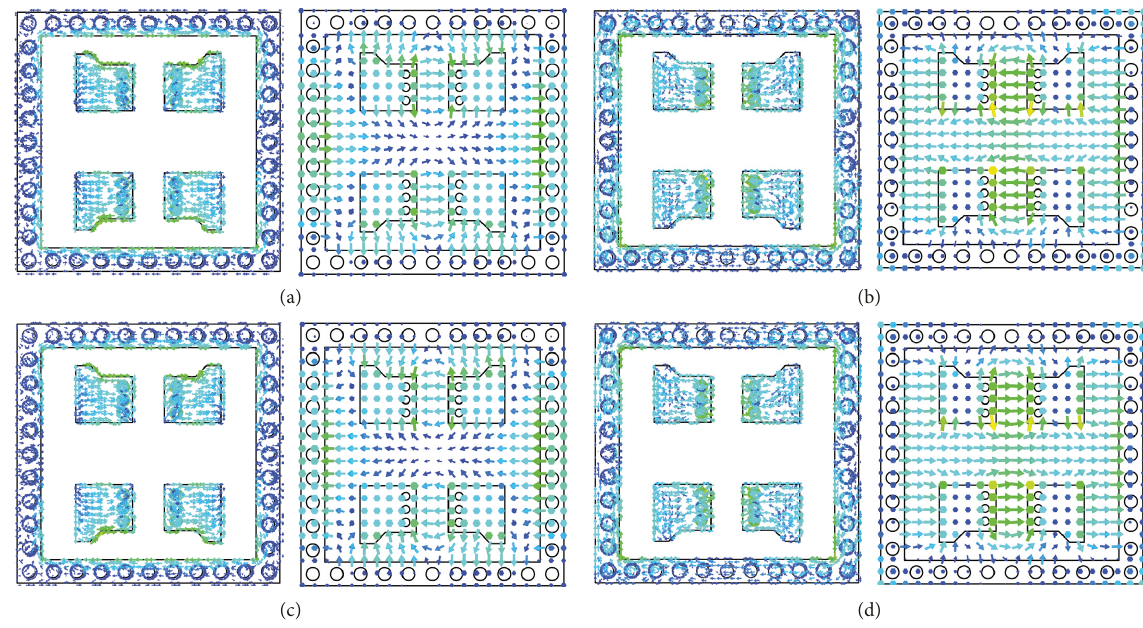
Figure 4: Surface current distributions and E-field distributions of the proposed antenna at (a) t � 0, (b) t � T /4, (c) t � T /2, and (d) t � 3 T /4.